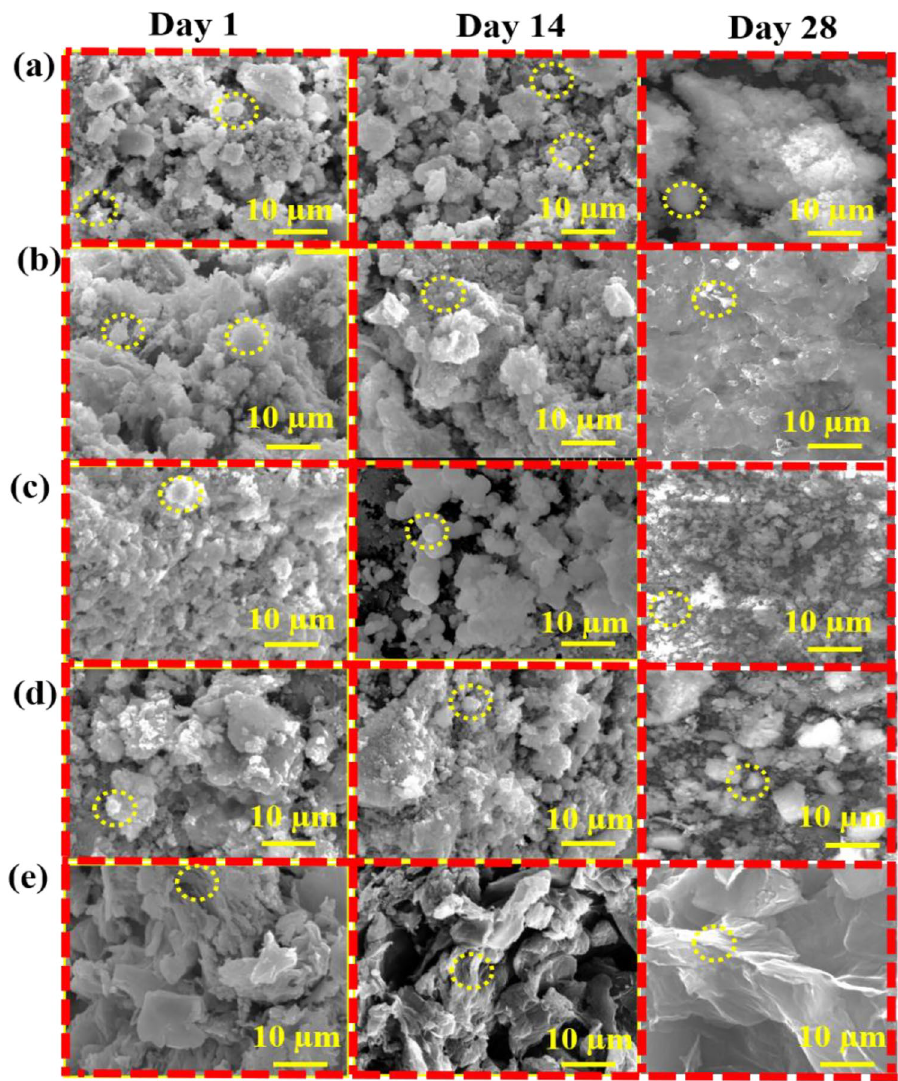
Figure 2. Scanning Electron Microscope (SEM) images of ( a ) BG, ( b ) BG/GO, ( c ) BG (Na-free), ( d ) BG (Na-free)/GO, and ( e ) GO nanocomposites after